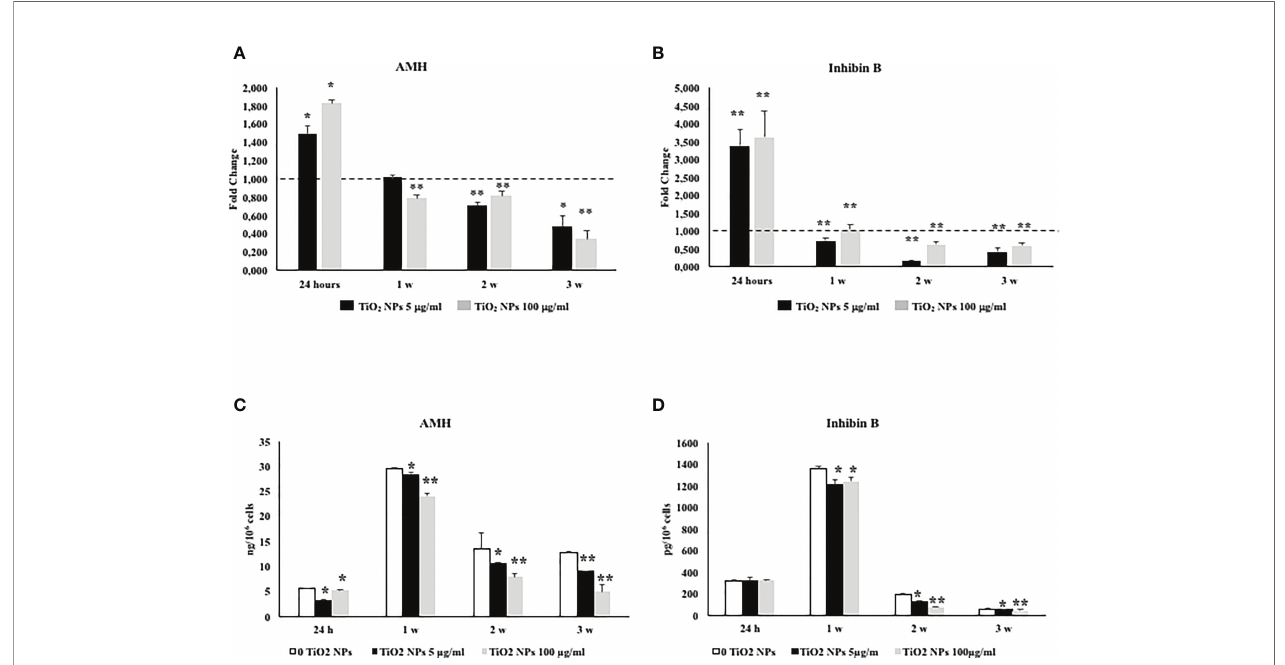
FIGURE 7 | Real-time PCR analysis of SCs functionality. Gene expression of AMH (A) , and inhibin B (B) in SCs at 24 h and 1, 2, and 3 weeks of incubation with TiO 2 NPs 5 (black bar) and 100 µg/ml (grey bar). ELISA assay of (C) AMH and (D) inhibin B secretion in SCs at 24 h and 1, 2, and 3 weeks of incubation with TiO 2 NPs 5 (black bar) and 100 µg/ml (grey bar). Data represent the mean ± SEM (* p < 0.05 and ** p < 0.001 vs. unexposed SCs (0 TiO 2 NPs, black dotted line) of three independent experiments, each performed in triplicate).